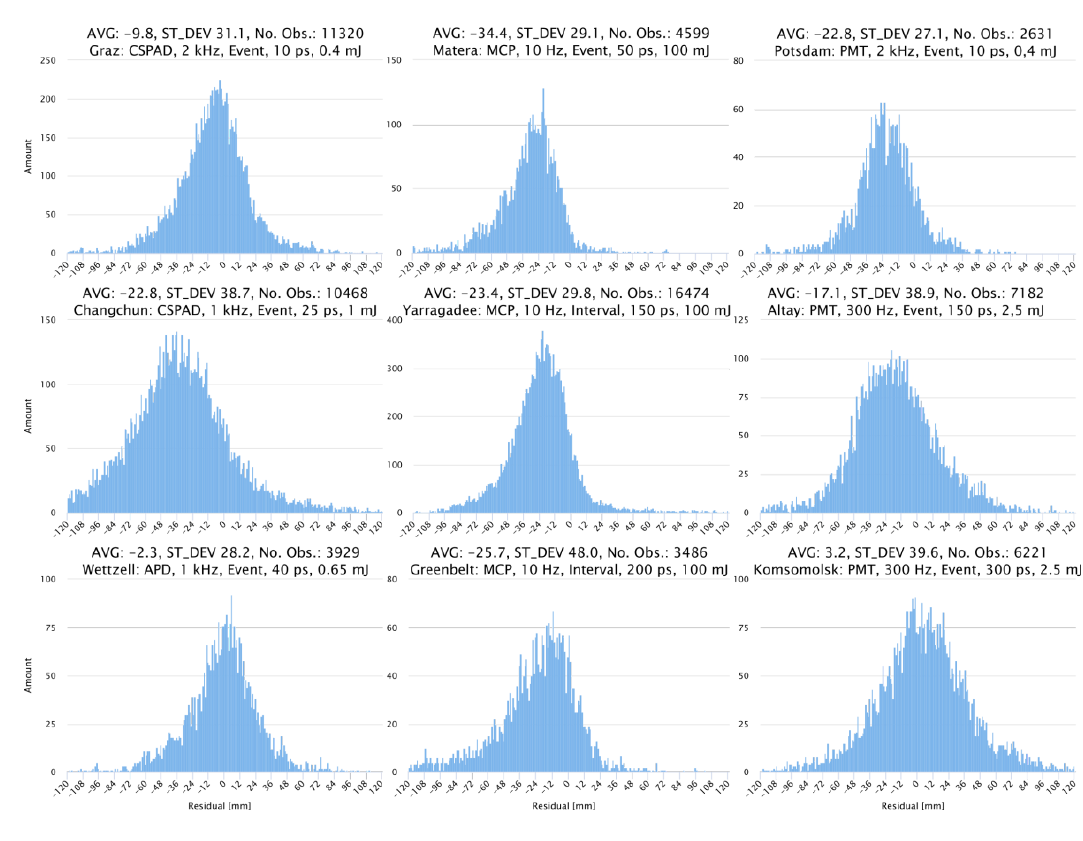
Figure 6. Histograms of SLR residuals related with particular laser stations; Dataset from August 2015–July 2017, consisted of only SLR residuals related to GLONASS-M satellites with uncoated LRA. Abbreviations used: AVG, average; ST_DEV, standard deviation; No. Obs., number of observations. Station characteristics included in a title in order: place, detector type, max repetition rate (Hz), timer type, pulse width (ps), max energy